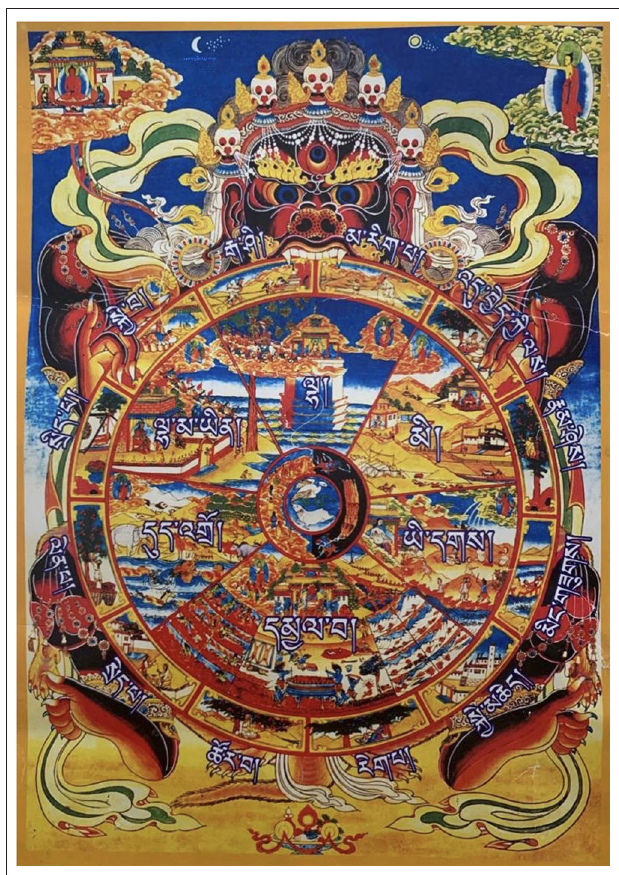
FIGURE 1 | Bhavacakra (Wheel of Life). Held by Yama, the god of death, the wheel within the mirror represents the nature of life, death, and rebirth according to one’s karma. Image provided with permission by Lobsang